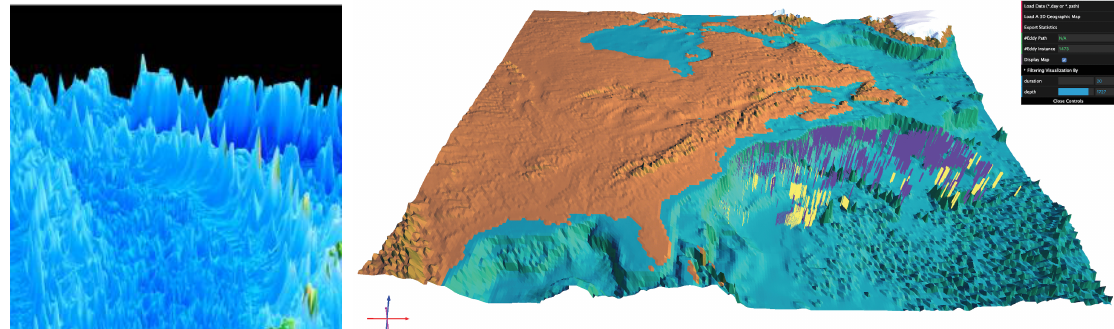
Figure 13. Left: Sea floor mapping from GPlates [82] showing the Marianna Arc in the Pacific Ocean. Right: Interface with dat.GUI showing Ocean eddies during the year 2007 close to a coastline. Various ocean eddies are categorized in different colors, yellow depicting cyclonic (water moving counterclockwise) eddies and purple depicting anti-cyclonic eddies (water moving clockwise). Scientist can identify that yellow/cyclonic eddies are more in the south, while purple ones are in primarily located in the north. Source: